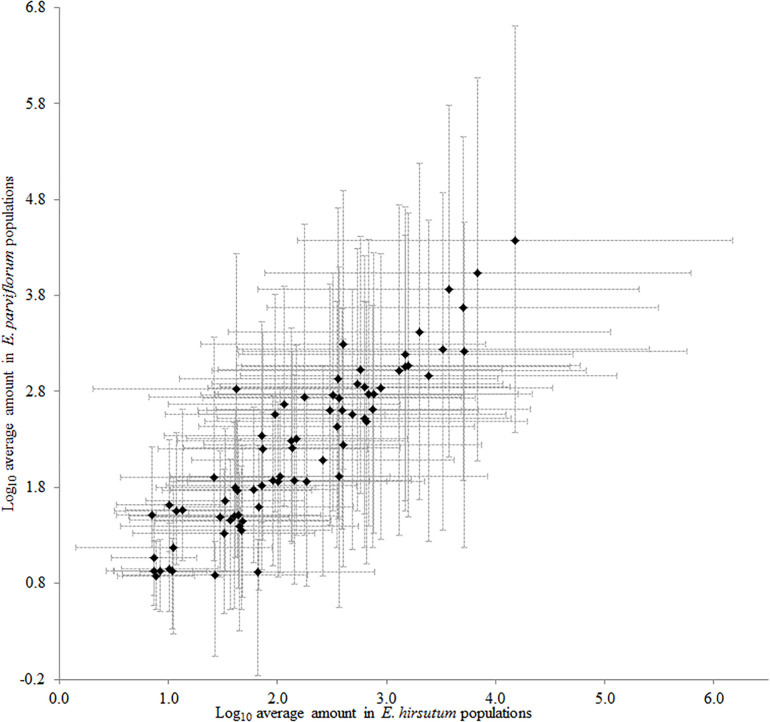
The similarity between E. hirsutum and E. parviflorum in the amount of 46 secondary metabolites (Pearson’s r = 0.91, R2 = 0.82, P < 0.0001).